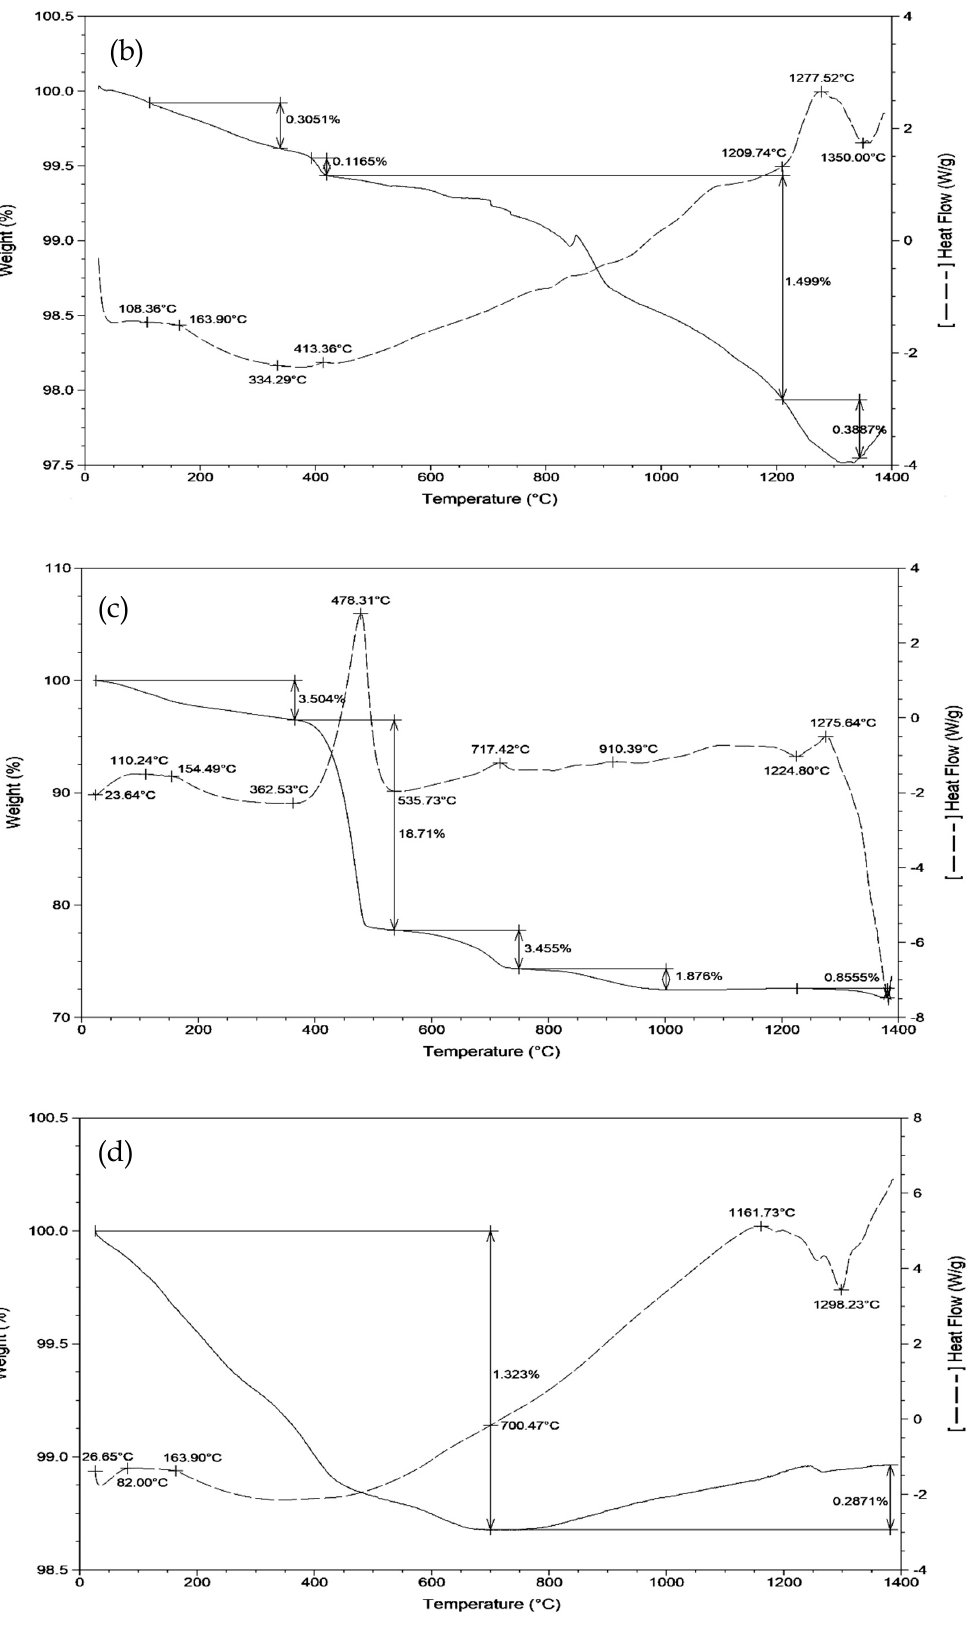
Figure 3. Comprehensive thermal analysis (DSC-TG) curves of the raw materials: ( a ) petroleum coke desulfurization slag; ( b ) fly ash; ( c ) carbide slag; ( d )